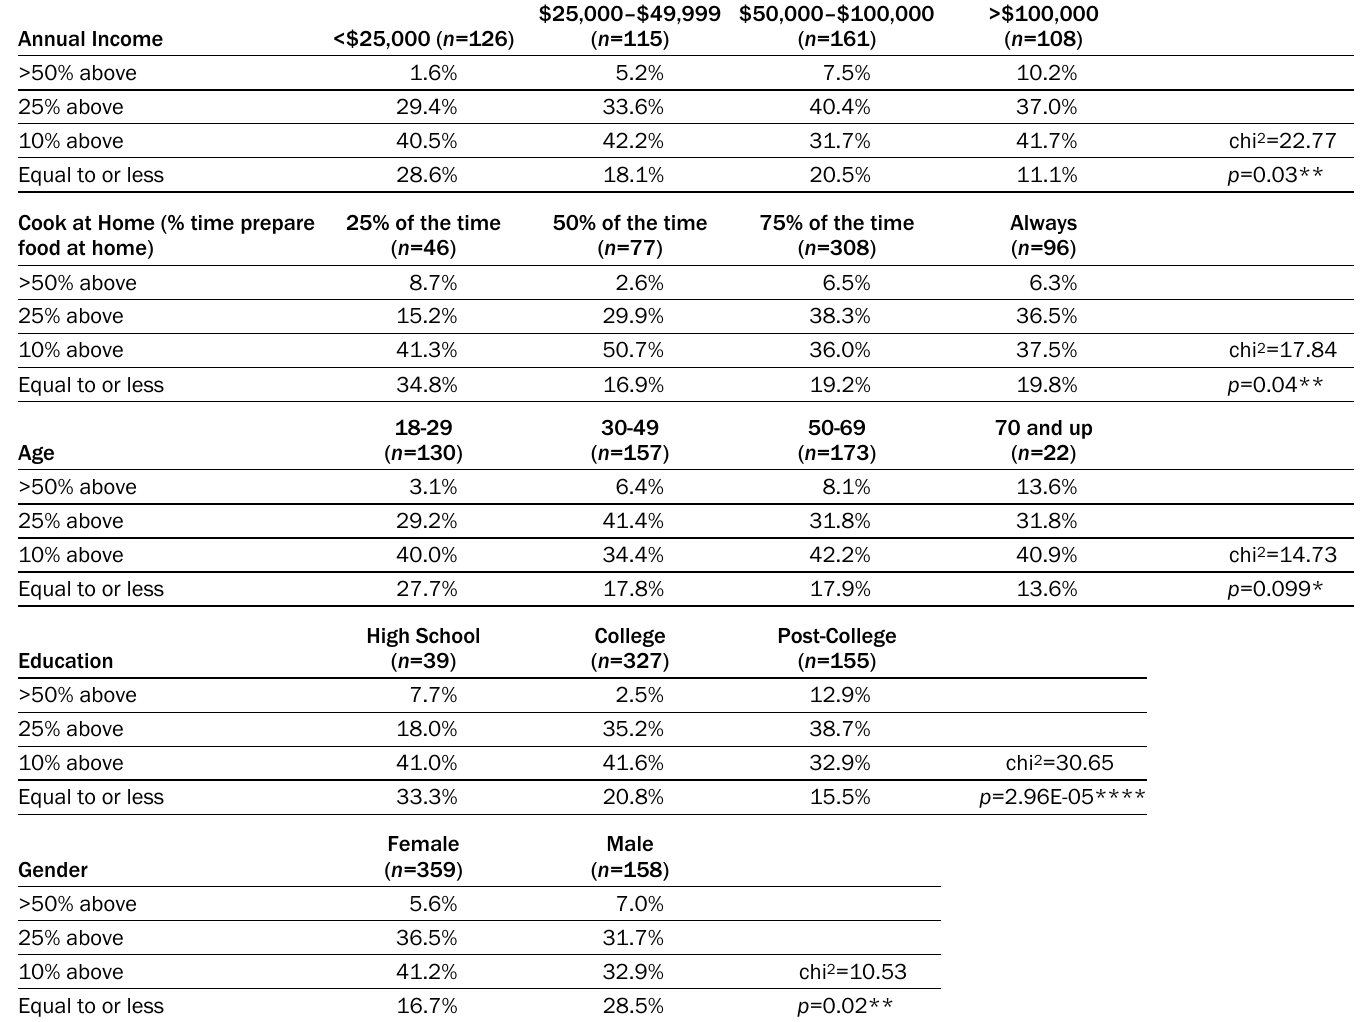
Table B2. Consumer Willingness to Pay for Local Foods, % Above Typical